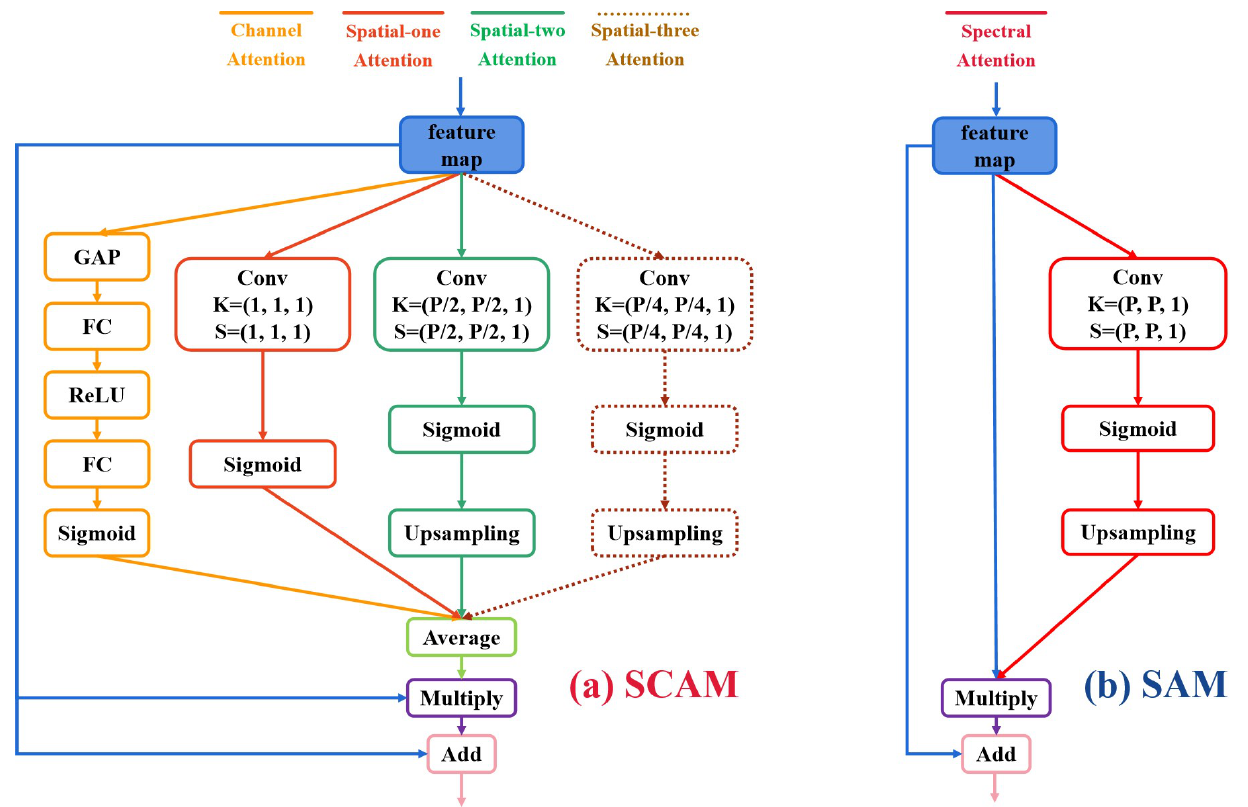
Figure 2. The architecture of the proposed dual-attention model. ( a ) The spatial & channel attention module (SCAM); ( b ) the spectral attention module (SAM). GAP, FC, K, S, P represent the global average pooling, the fully connected layer, the kernel size, the stride and the patch-width/height, respectively. ReLU and Sigmoid denote the activation functions. The total weight is generated by aggregating the weights of three (or four)